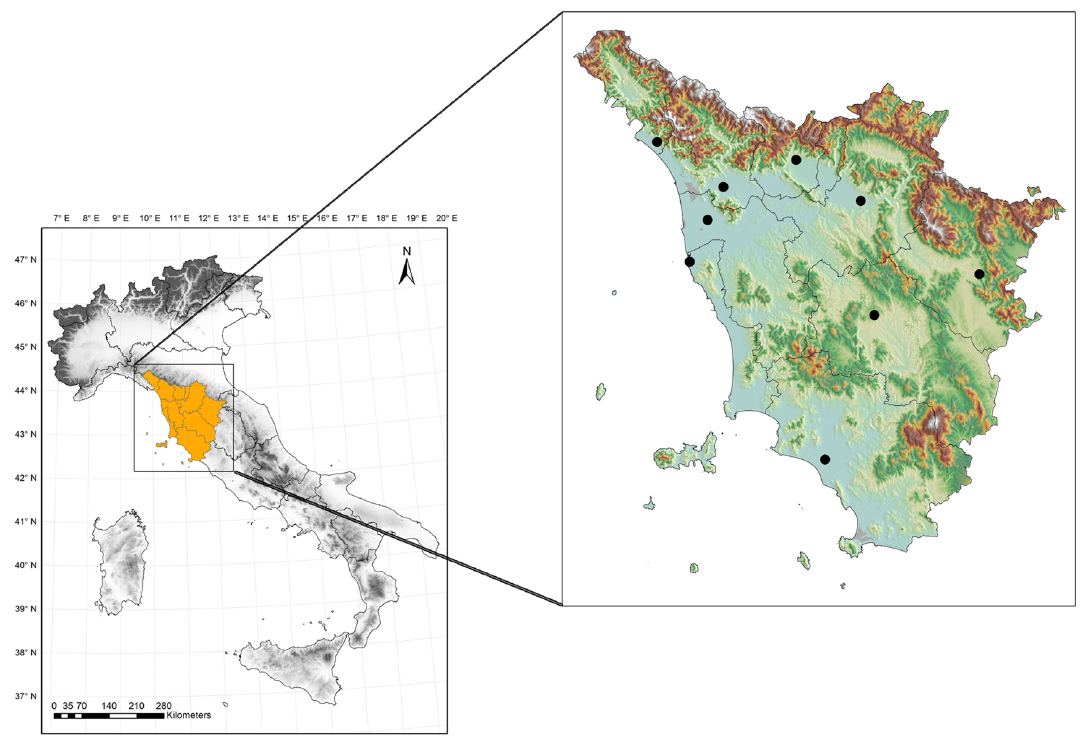
Figure 1. Area of interest of the drought